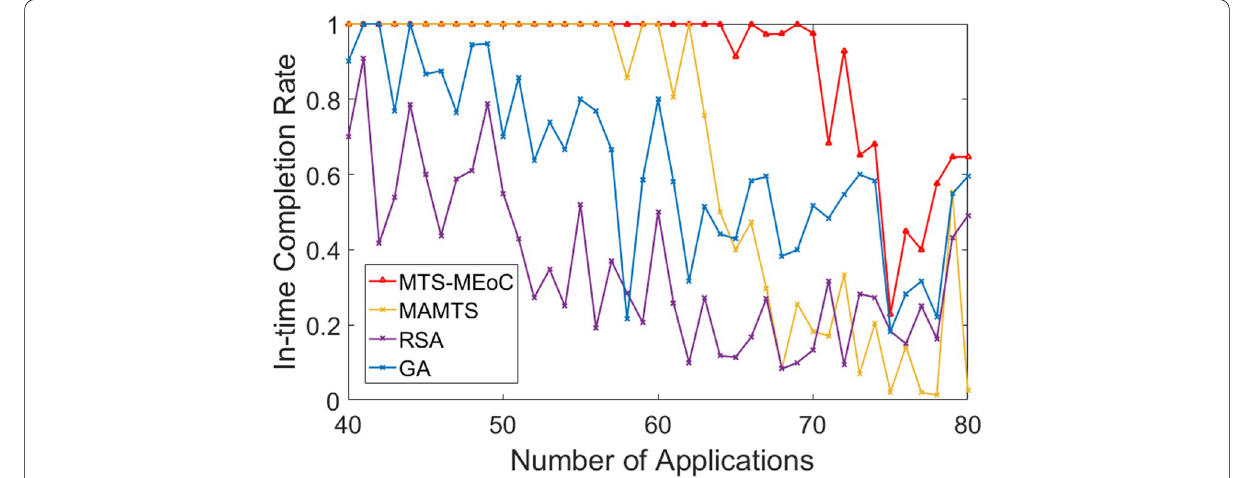
Fig. 6 The in-time completion